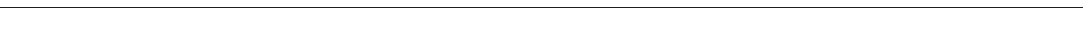
Fig. 1 RNA-Seq reveals lincRNAs correlating with brown fat function in vivo. a , b Plot of BAT ( a ) mRNA or ( b ) lincRNA expression after HFD or CD feeding (RNA-Seq, n = 2 per biological condition). c , d Plot of BAT c mRNA or d lincRNA expression after 24 h of 4 °C or 22 °C (RNA-Seq, n = 2 per biological condition). e – g BAT, scWAT, and vWAT expression of e Elovl3 f Ucp1 , and g H19 expression in CD-fed mice ( n = 3 – 5 per given tissue, left), in CD-fed mice housed at 22 °C ( n = 4) versus 24 h of 4 °C ( n = 3, middle) and HFD-fed ( n = 3 for Elovl3 and Ucp1 , n = 7 for H19 ) versus CD-fed mice ( n = 3 for Elovl3 and Ucp1 , n = 7 for H19 , right, qRT-PCR. h , i scWAT expression of Ucp1 and H19 in h mice housed at 22 °C ( n = 2 for Ucp1 , n = 4 for H19 ) versus 24 h of 4 °C ( n = 2 for Ucp1 , n = 4 for H19 ) and i HFD-fed ( n = 4) versus CD-fed ( n = 3 for Ucp1 , n = 4 for H19 ) mice. j vWAT Ucp1 and H19 expression in mice housed at 22 °C versus 24 h of 4 °C ( n = 2 for Ucp1 , n = 4 for H19 ). Unless stated, bar graphs represent mean ± s.e.m. with all data points plotted and unpaired, two-tailed Student ’ s t -tests were used to assess statistical signi fi cance. * p < 0.05, ** p < 0.01, *** p < 0.001. If applicable p -values are indicated within